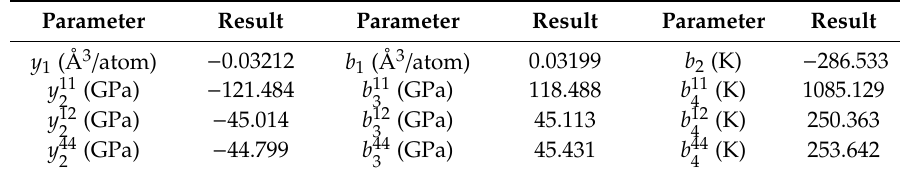
Table 2. Fitted parameters for the relationships of the elastic constants and the changes of temperatures and